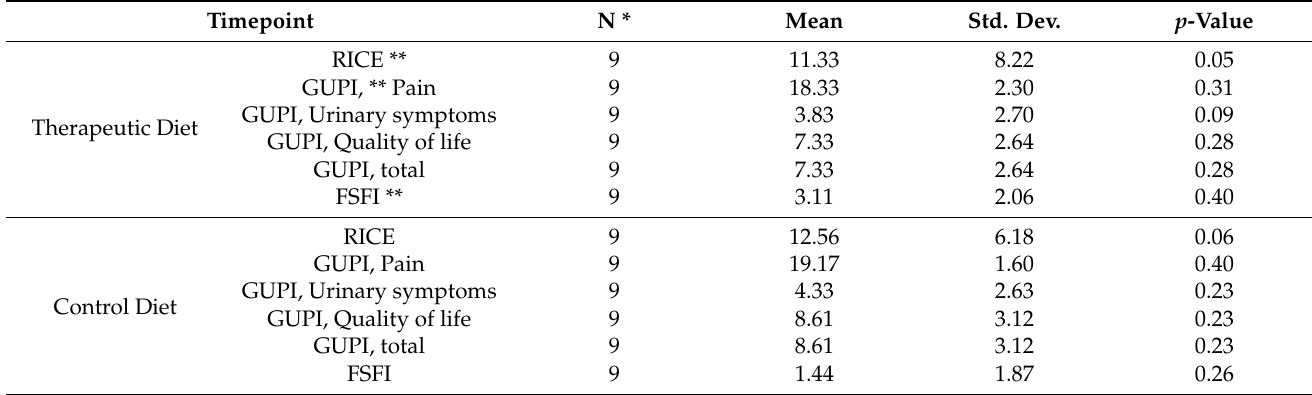
Table 5. Descriptive statistics and results of paired T-tests of disease activity